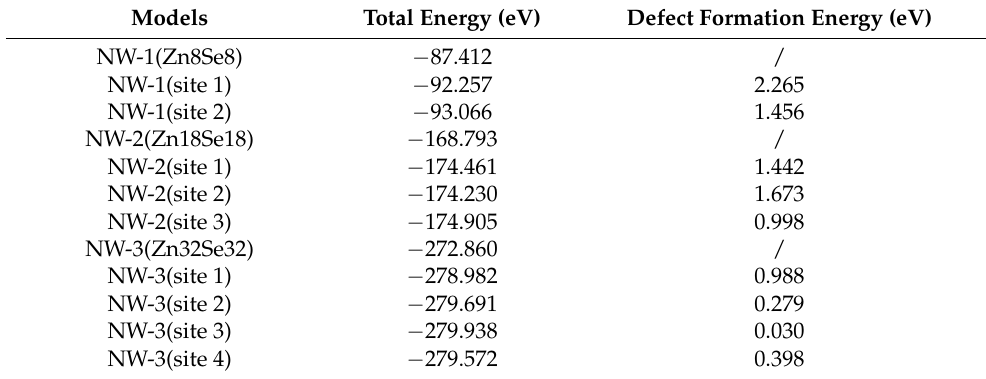
Table 1. The total energy and defect formation energy of Cr 2+ :ZnSe NWs in different sizes. Models